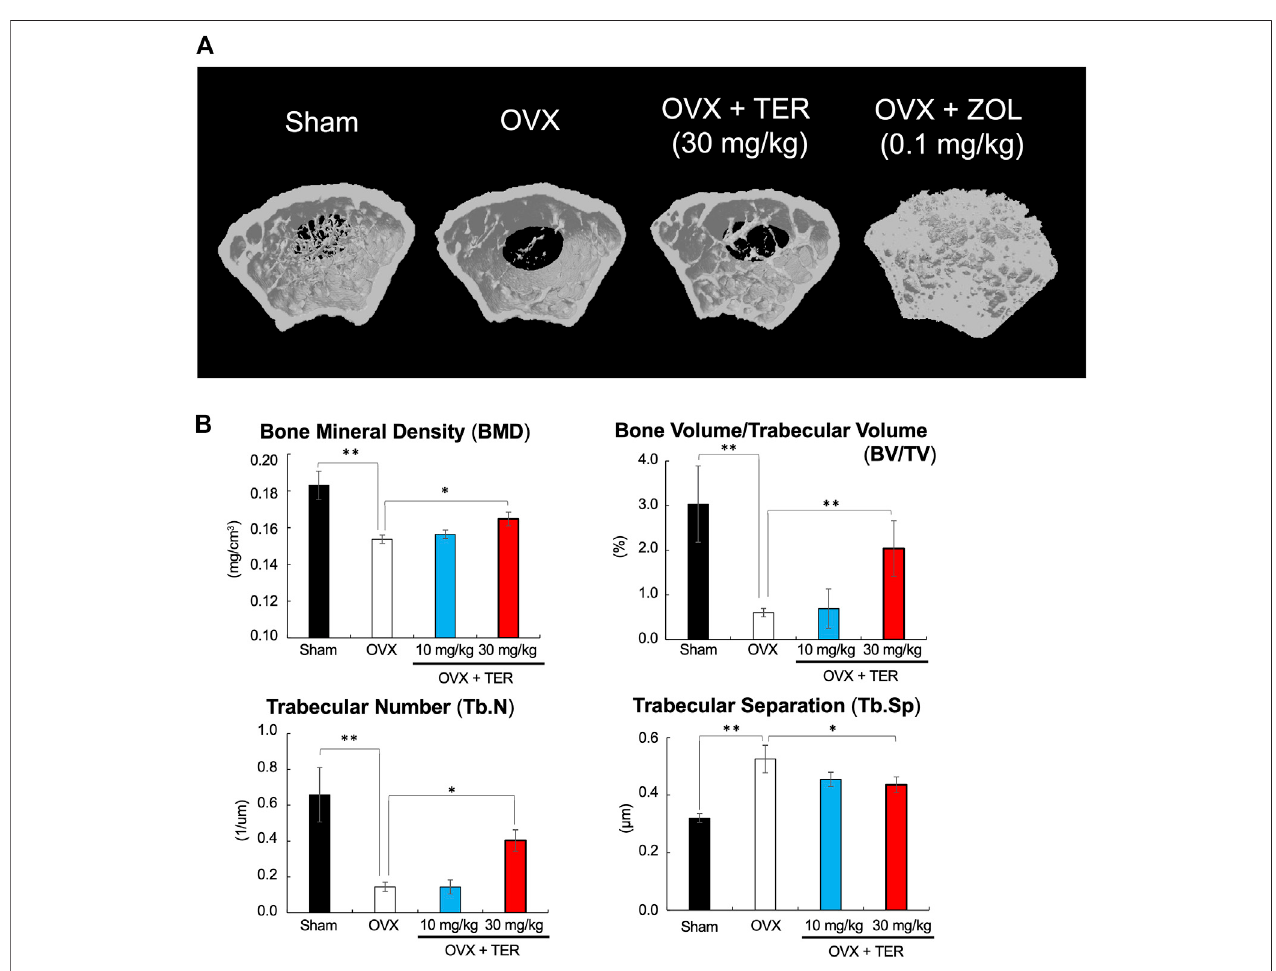
FIGURE 3 | Synthetic TER suppressed ovariectomy-induced bone loss. (A) The 3D model of the femur was created within 3 mm just below the growth plate (the preferredsiteoffemoralfracture). (B) Bonemineraldensity(BMD,mg/cm 3 ),bonevolume/trabecularvolume(BV/TV, %),trabecularnumber(Tb.N,1/ μ m),andtrabecular separation (Tb.Sp, μ m) were analyzed in each group ( n (cid:1) 6 – 7, ** p < 0.01, * p < 0.05, ANOVA/Tukey – Kramer test). Sham: PBS-treated non-osteoporosis mice; OVX: PBS-treated osteoporosis mice; OVX + TER: TER-treated osteoporosis